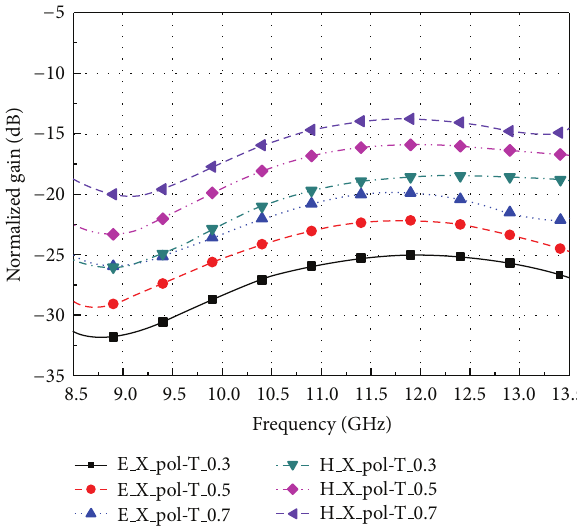
Figure 7: Cross-polarized levels versus frequency with different substrate thicknesses.